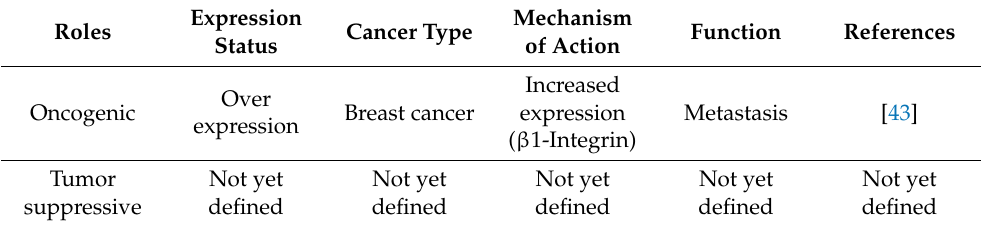
Table 3. Roles of RAB11B in cancer.